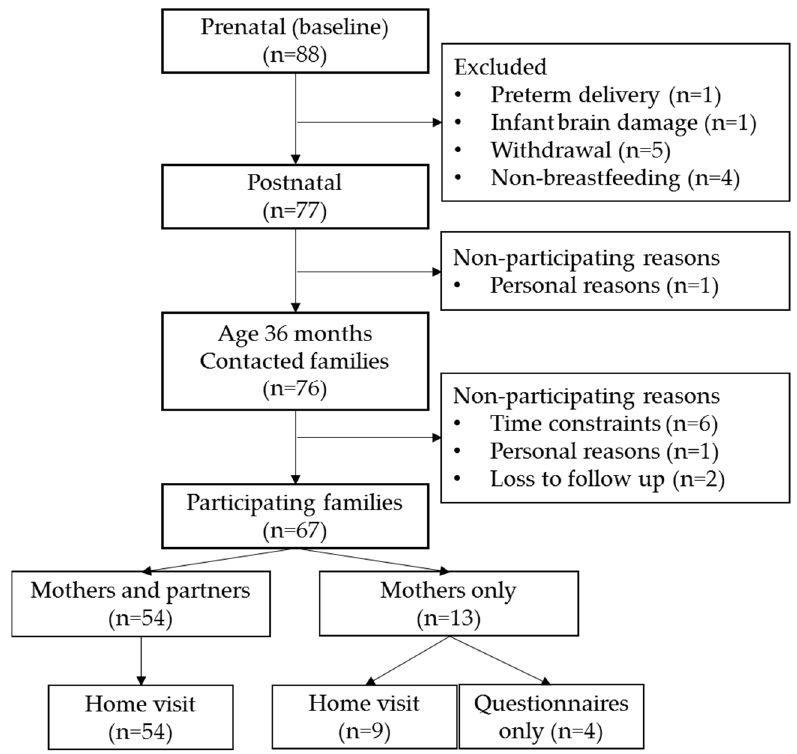
Figure 1. Flow chart of participating families.